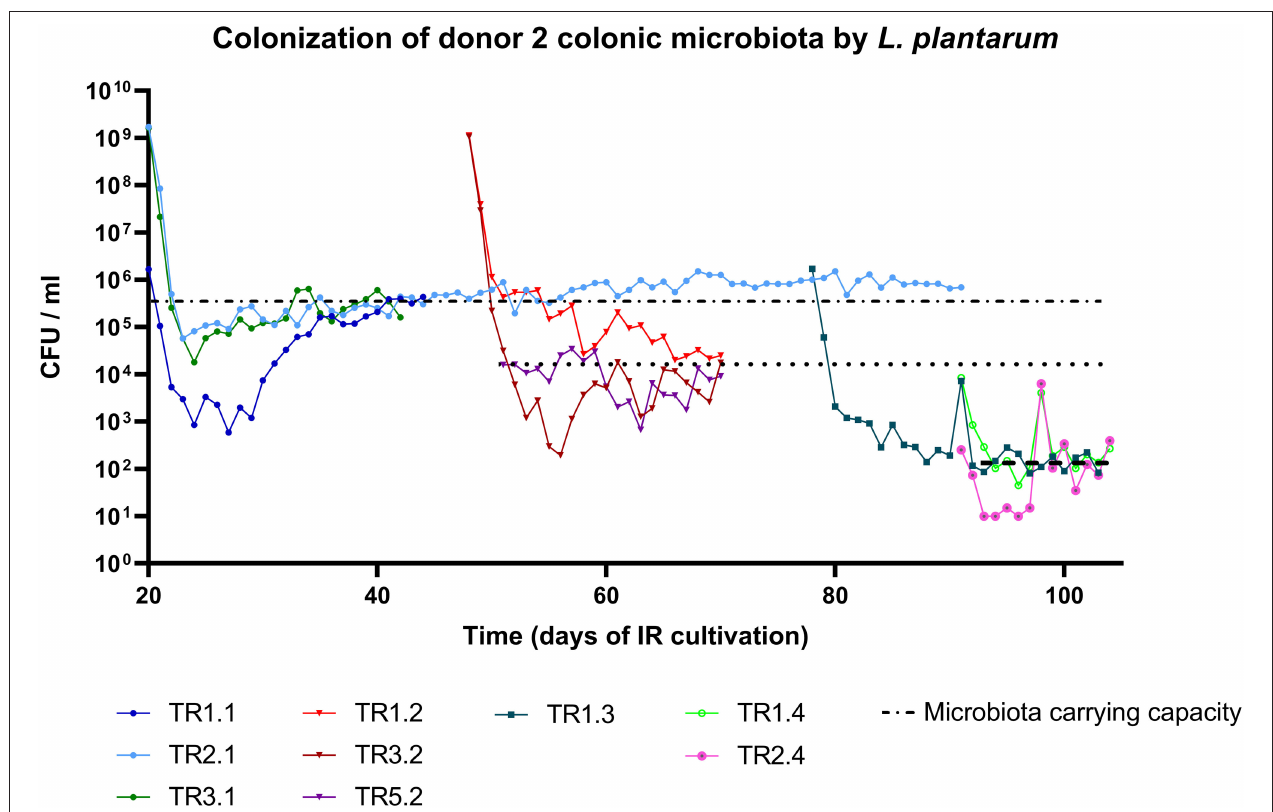
FIGURE 3 | Change in carrying capacity of in vitro colonic microbiota of donor 2 over time of IR microbiota cultivation. The x-axis depicts the age of the colonic microbiota in the IR containing colonic microbiota of donor 2 and the y-axis represents L. plantarum viable cell count per ml reactor effluent. The dashed lines indicate the changing carrying capacity for L. plantarum with the age of the colonic microbiota.